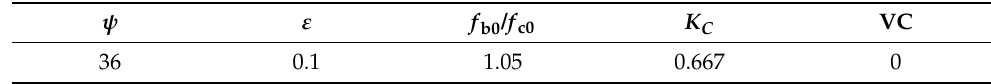
Table 3. Plasticity of ECC input data.